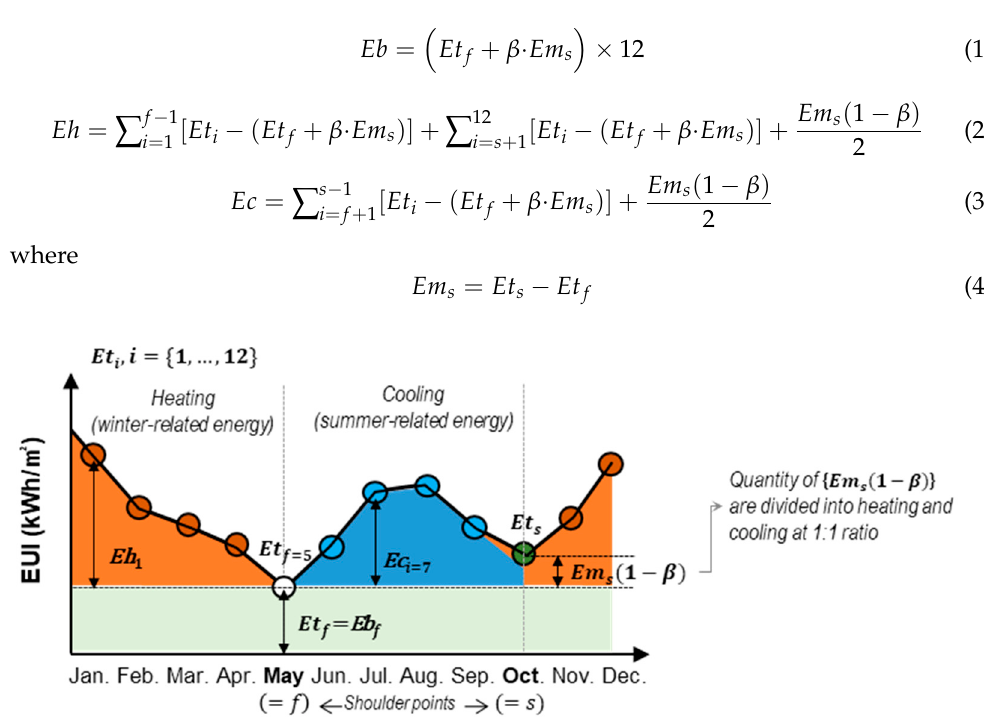
Figure 5. Monthly energy usage patterns in a temperate climate with four distinct seasons.